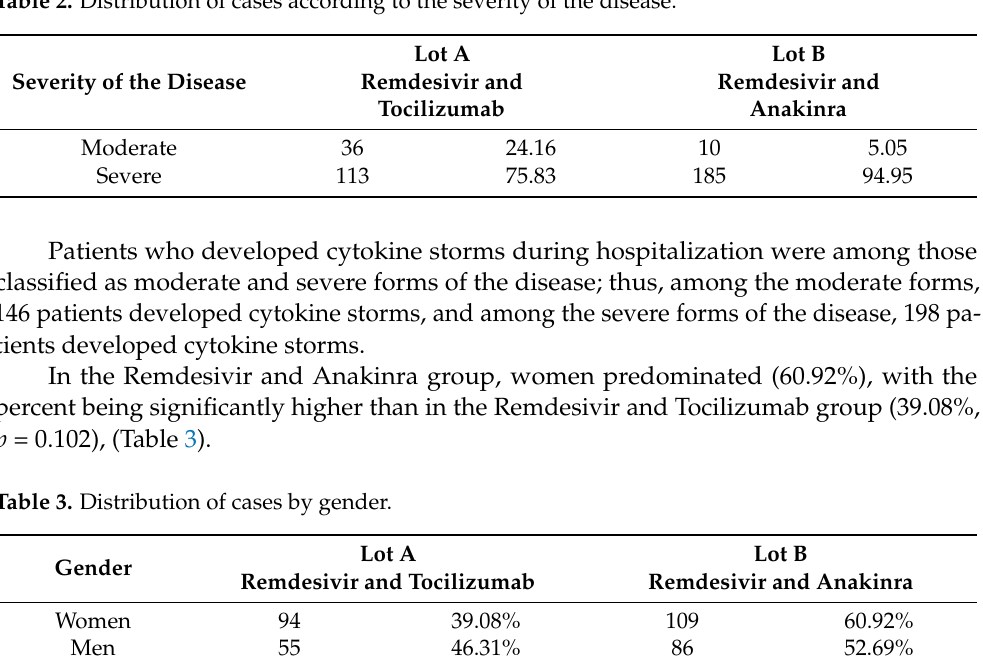
Table 2. Distribution of cases according to the severity of the disease.